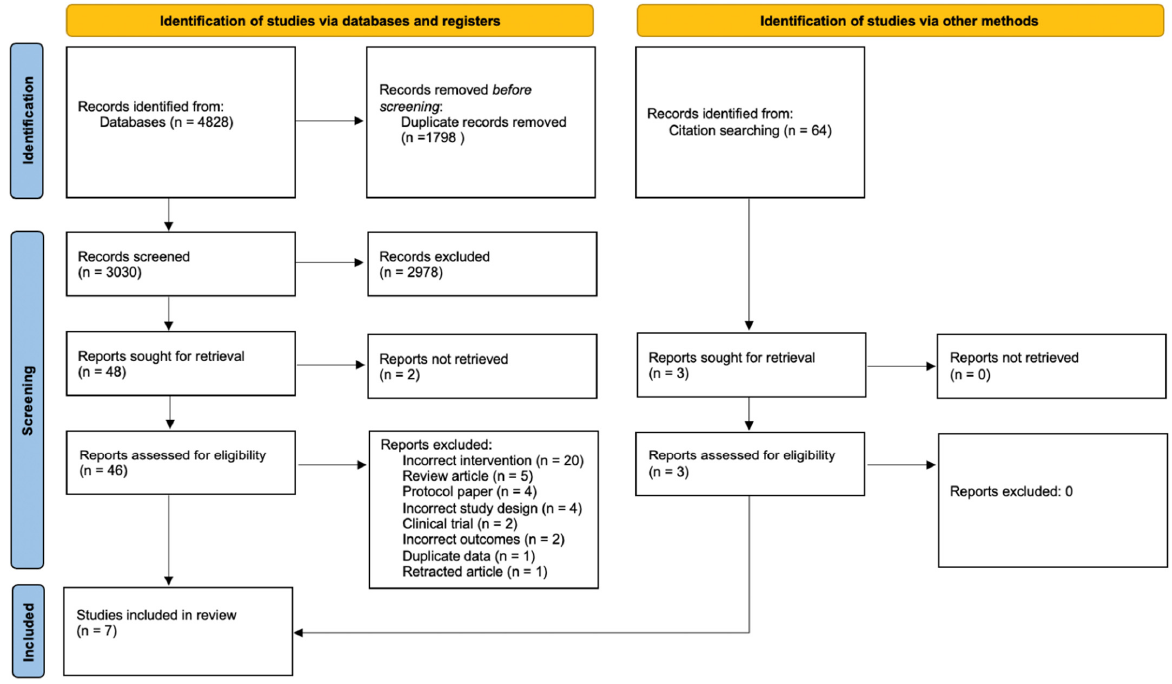
Figure 1. PRISMA flow diagram of studies included in the review.